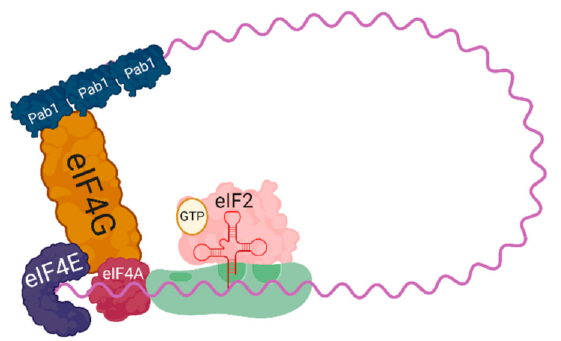
Figure 1. A schematic of a 43S preinitiation complex (the 40S small ribosomal subunit with eIF2 bound to GTP, and Met-tRNA Met ) loaded onto an mRNA, bound by eIF4F (composed of the cap binding protein eIF4E, the helicase eIF4A, and the scaffolding protein eIF4G). The scaffolding protein eIF4G spans to bind the poly-A binding protein, Pab1, resulting in circularization of the transla- tional